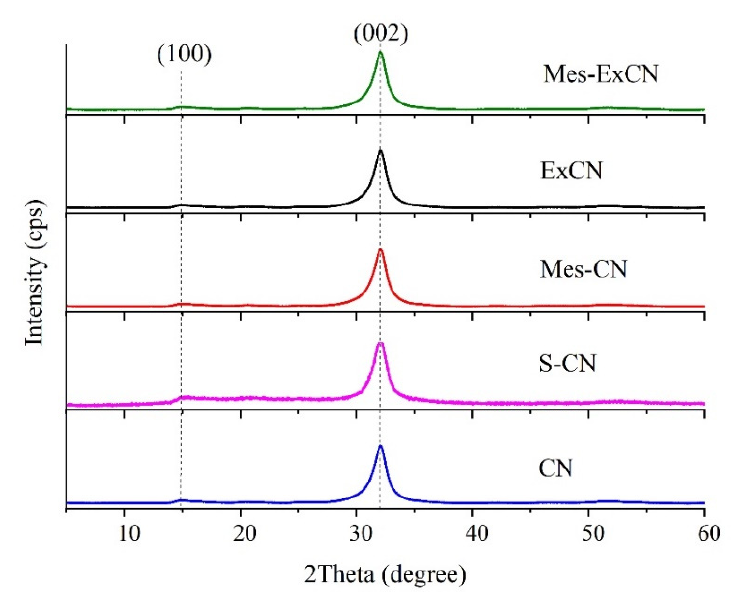
Figure 3. X-ray powder diffraction (XRD) patterns of CN-based nanomaterials.